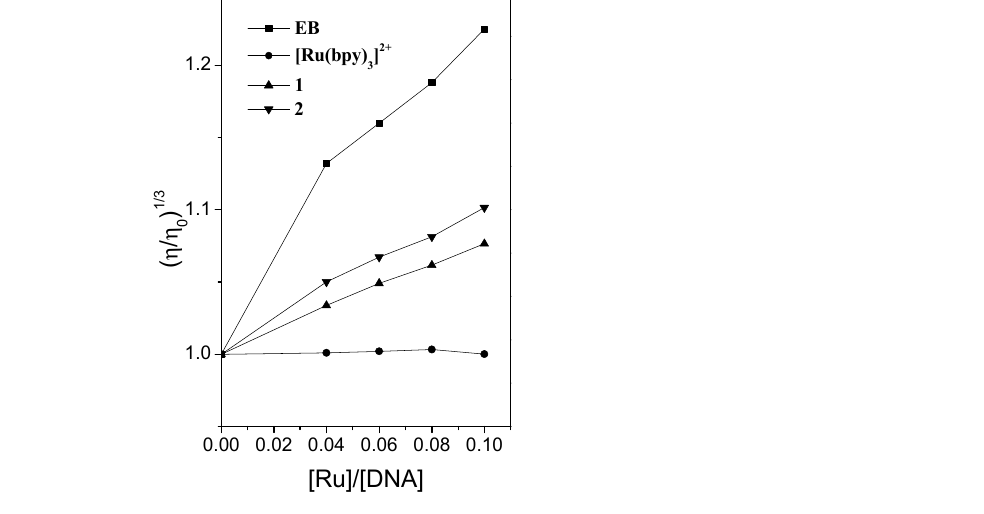
(phen) with larger hydrophobicity compared to complex 1 (bpy), which results in larger DNA affinity [30].